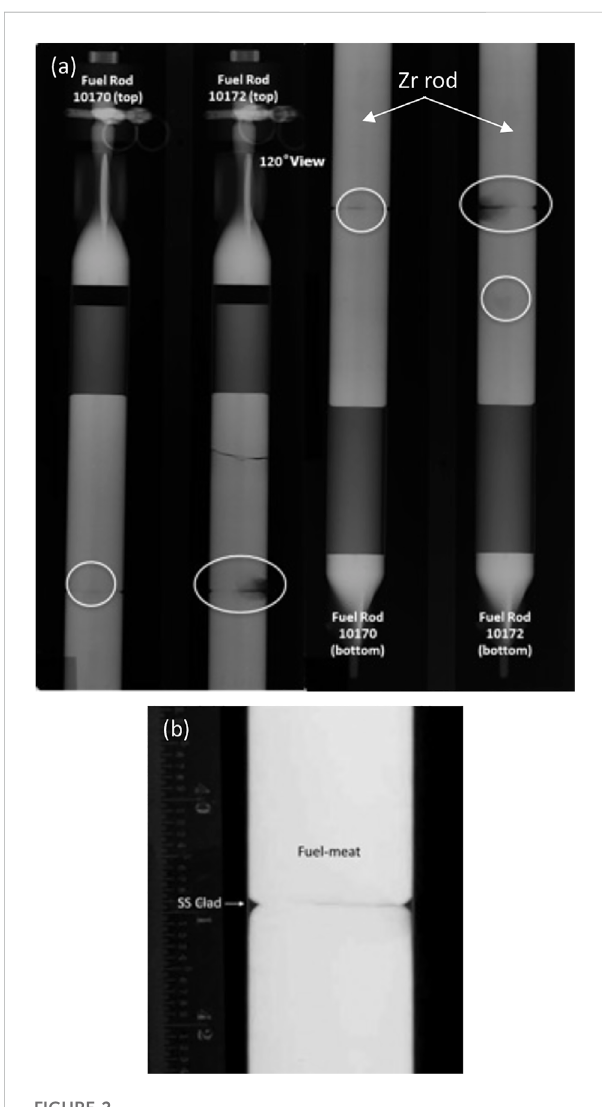
Fuel Rods 10170 and 10172 shown for the 120-degree view (A) . The circled regions are possible dehydride locations in the fuel meat. In (B) is shown the fuel meat to cladding interface for a local region of fuel rod